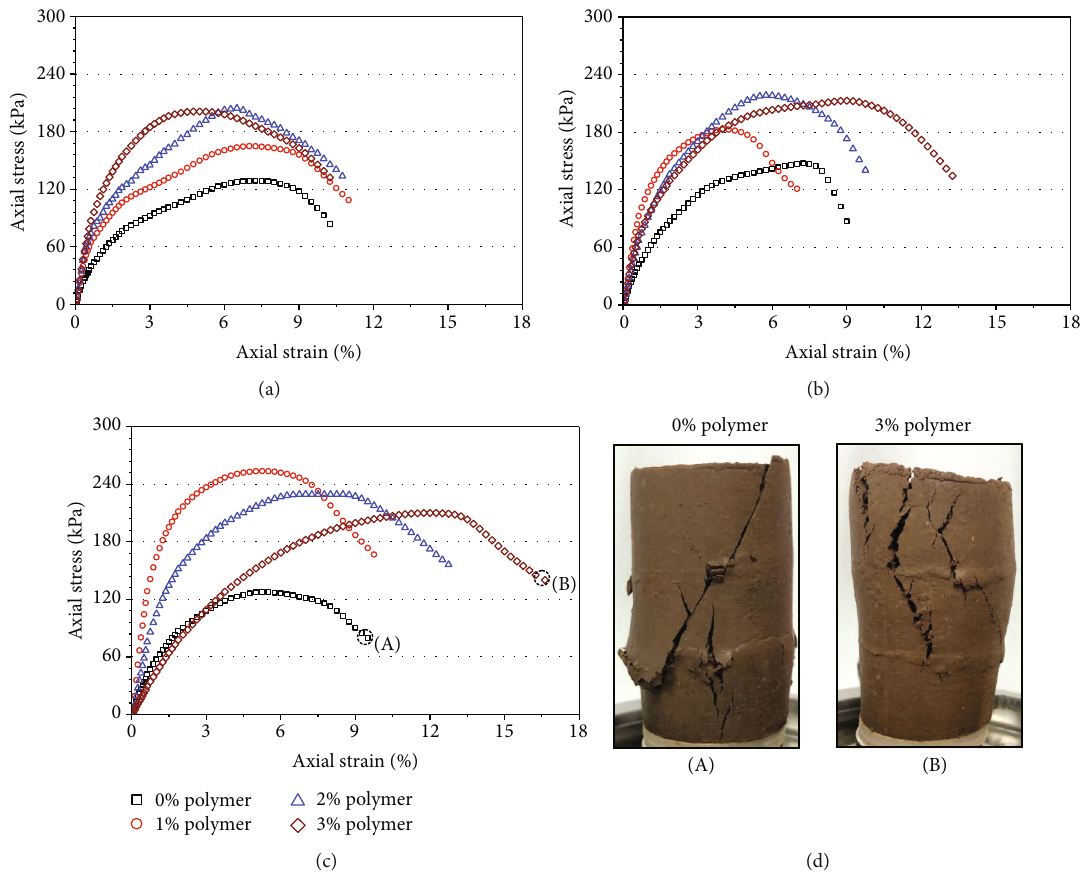
Figure 5: Typical stress-strain curves of the specimens in optimum water content condition after (a) 1-day curing, (b) 3-day curing, and (c) 9-day curing. And (d) failure patterns of the specimens treated by 0% and 3% polymer after 9 days of